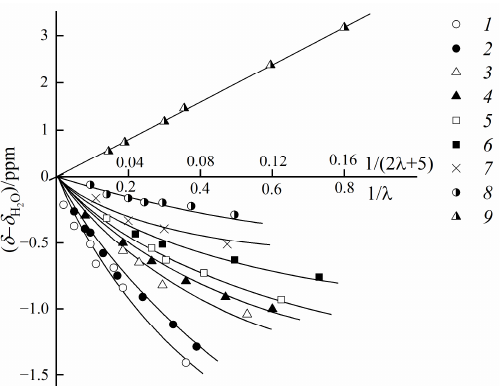
Figure 11. Dependences of chemical shifts of water on the moisture content of the MF-4SC membrane. Membrane ionic form: (1) Li + , (2) Na + , (3) K + , (4) Rb + , (5) Cs + , (6) Ba 2+ , (7) Ca 2+ , (8) Mg 2+ , (9) H + (adapted from [36]).